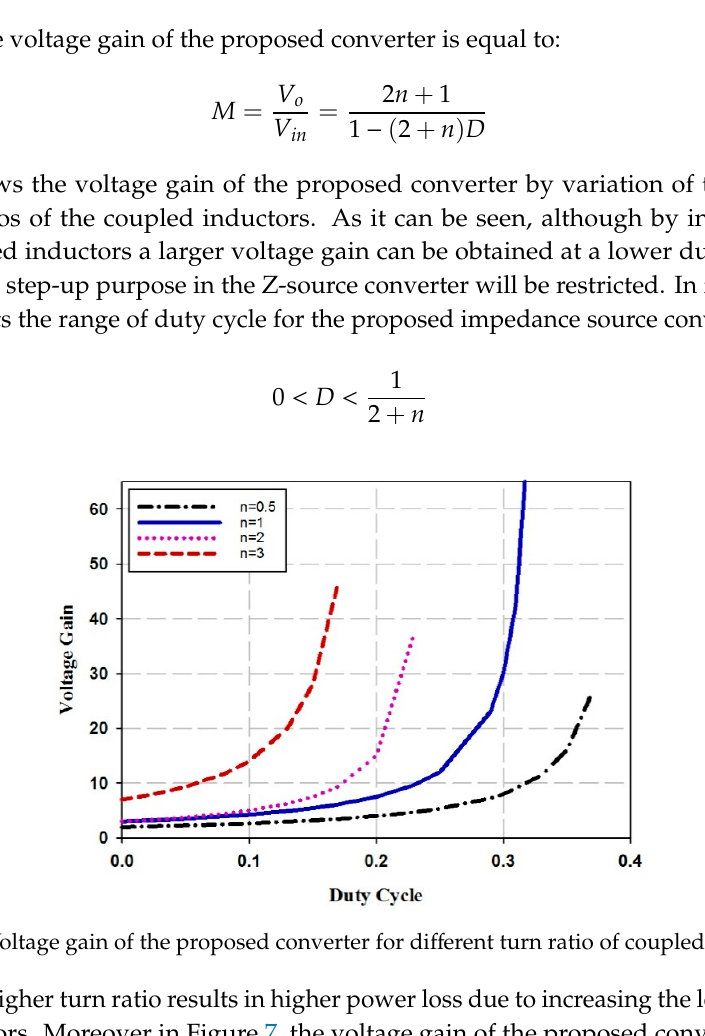
Figure 6. Voltage gain of the proposed converter for different turn ratio of coupled inductors.